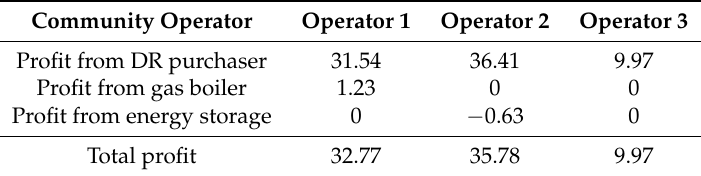
Figure 3. Bidding amount of 3 community operators. Table 2. Profit of 3 community operators ( × 10 3